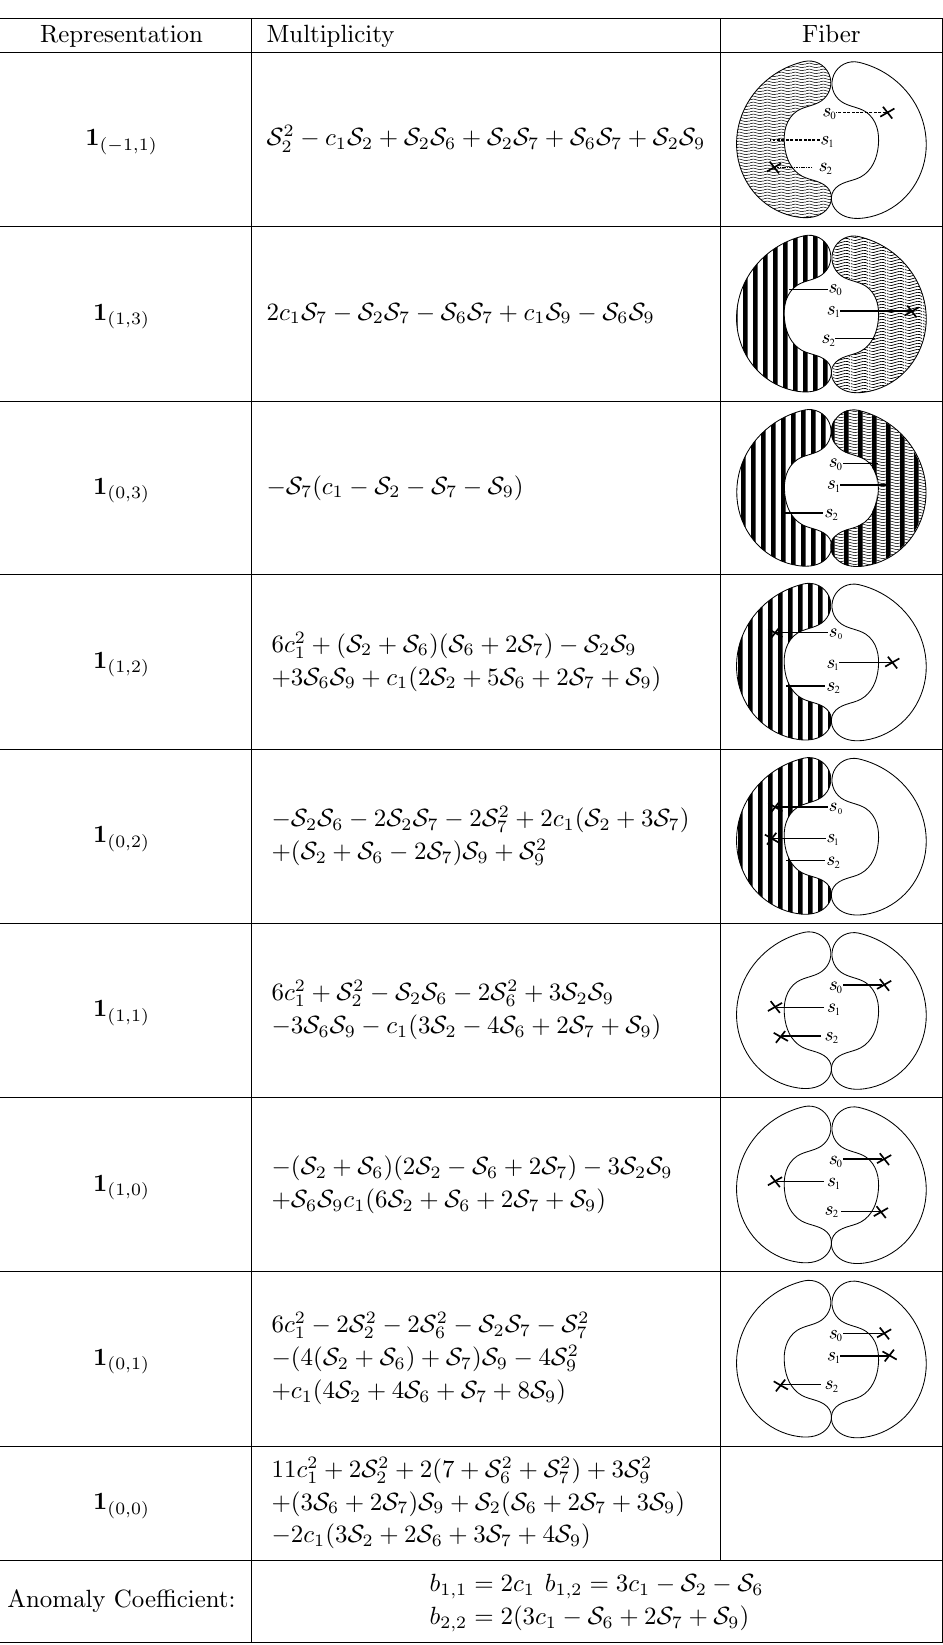
Table 6 . Summary of the charged matter representations and multiplicities under U(1) 2 and codimension two fibers of nef (21 ; 0) and its anomaly